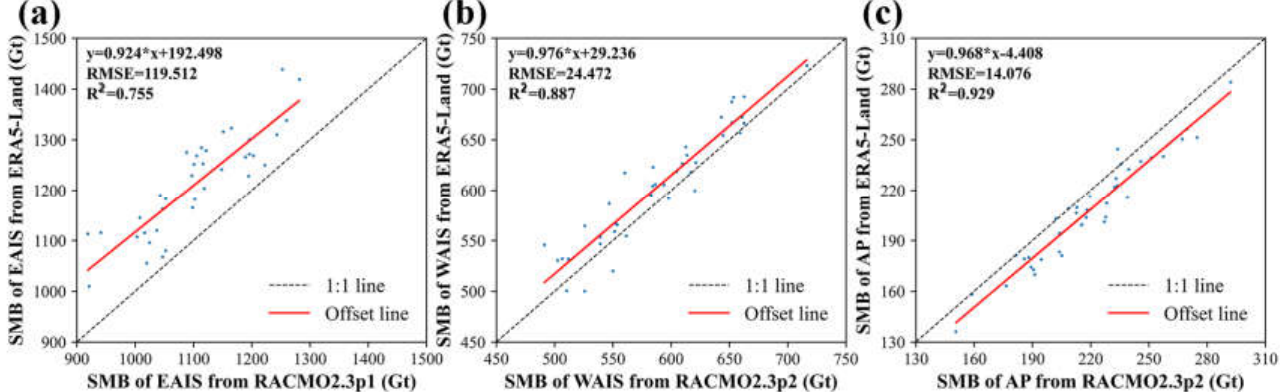
Figure 5. Comparison of annual SMB estimated from ERA5-Land and RACMO2.3 output. ( a ) The SMB of ERA5-Land against the SMB from RACMO2.3p1 in the EAIS from 1979 to 2015. ( b ) The SMB of ERA5-Land against the SMB from RACMO2.3p2 in the WAIS from 1979 to 2017. ( c ) The SMB of ERA5-Land against the SMB from RACMO2.3p2 in the AP from 1979 to 2017.